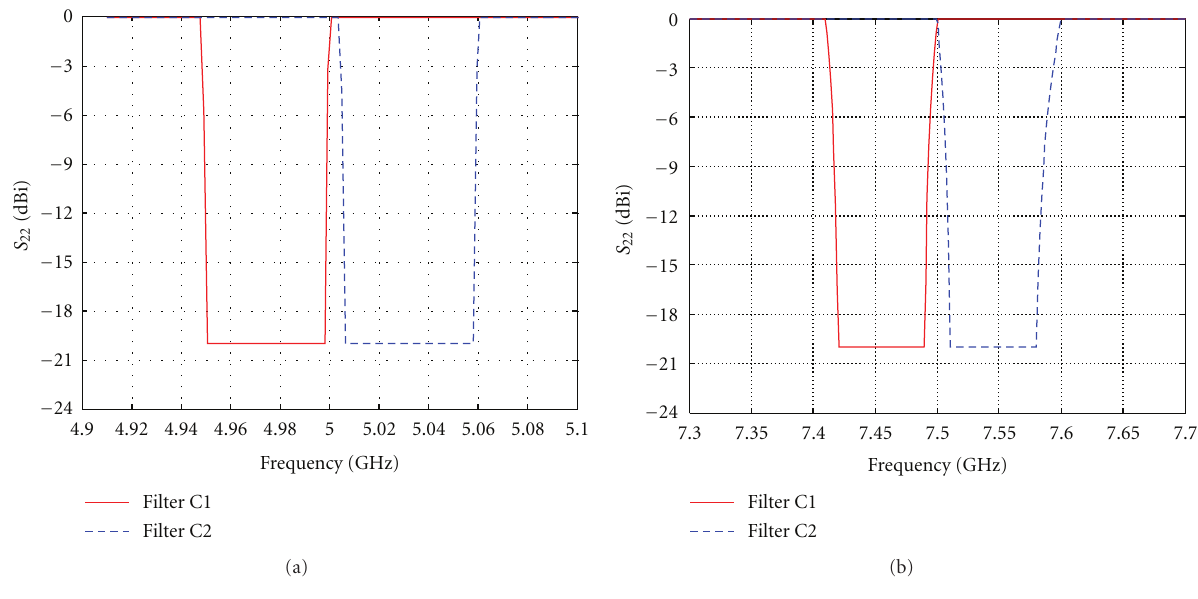
Figure 14: S22 magnitude of each filter at f L (a) and f H